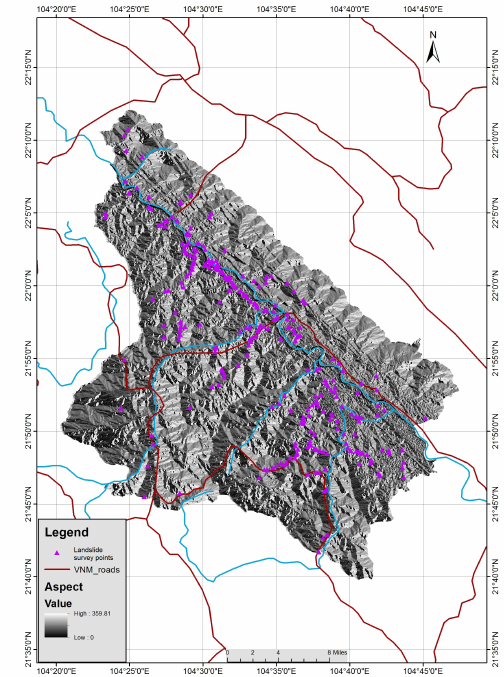
Figure 2. Landslide survey points last updated in 2013 superimposed with aspect